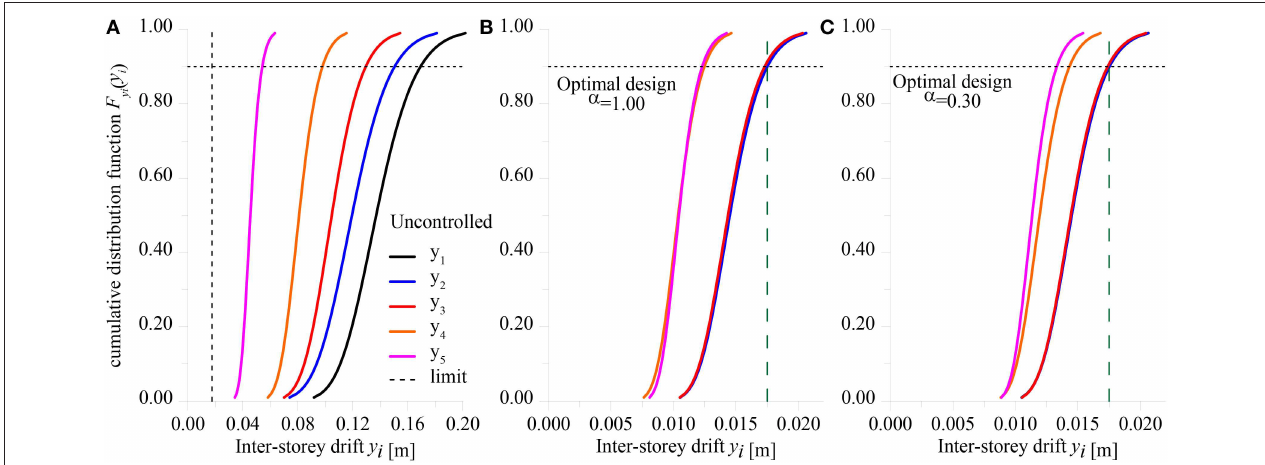
FIGURE 5 | Cumulative distribution functions of inter-story drifts. (A) Uncontrolled structure. (B) optimal design for α survival probability ¯ P s 0.90. =